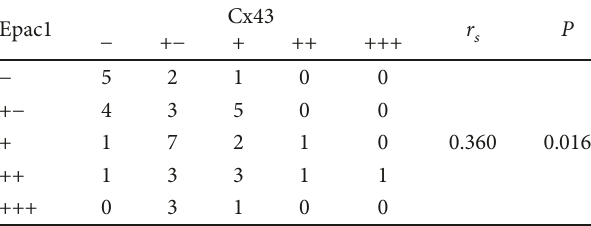
Note: r s is the spearman rank correlation coe ffi cient. Table 5: Correlation between Epac1 and Cx43 protein levels in rectal